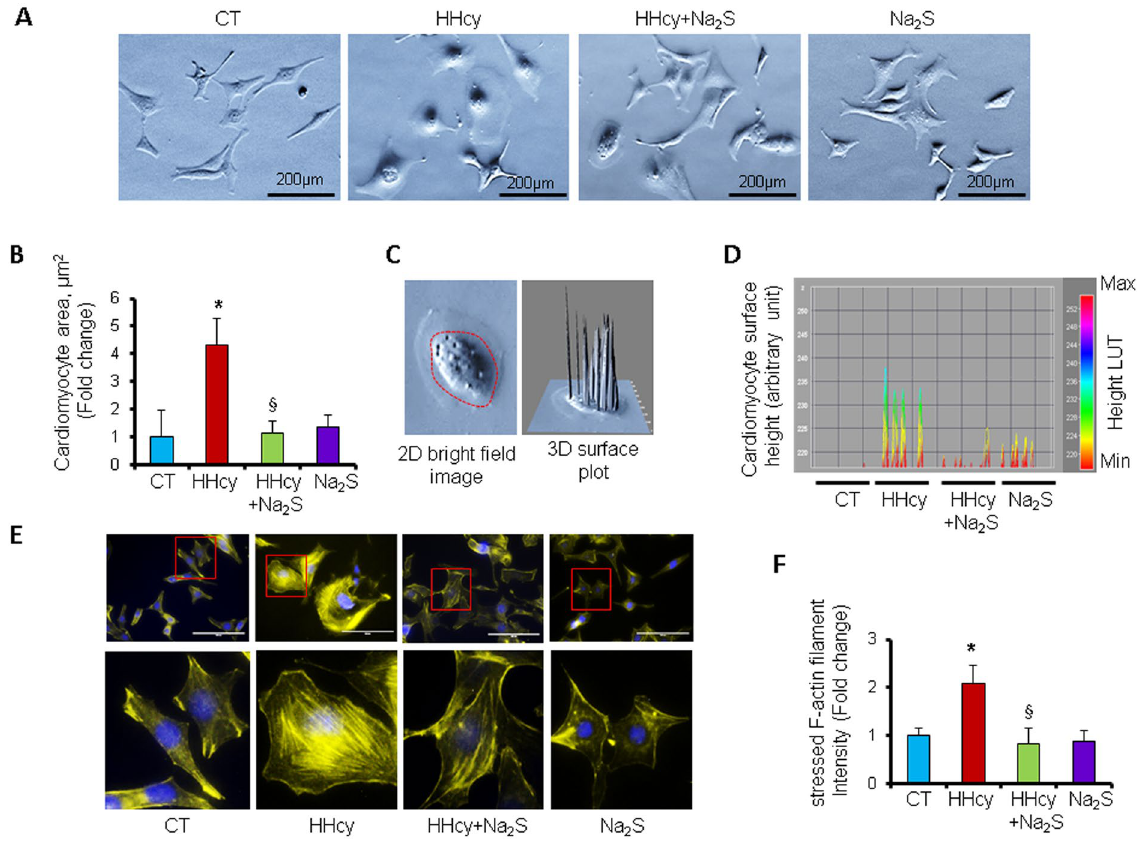
Figure 7. Hydrogen sulfide donor Na 2 S mitigates homocysteine-mediated increase in cardiomyocyte area and F-actin expression in HL1 cardiomyocytes. ( A ) Representative phase-contrast microscopic images showing the relative size of cardiomyocytes treated with either nothing (CT), 100 µ M of Hcy (HHcy), HHcy with 30 µ M of Na 2 S (HHcy + Na 2 S), or 30 µ M of Na 2 S (Na 2 S). ( B ) Quantification of cardiomyocyte area in the above four groups of cardiomyocytes. Values are represented as mean ± SEM. n = 20 cells per group from three independent experiments. ( C ) Representative 2D phase-contrast and 3-dimentional (3D) shadow spike plot of a cardiomyocyte. ( D ) The shadow spikes converted lookup table (LUT) showing the arbitrary height of cardiomyocytes in the above four groups. ( E ) Representative F-actin staining on cardiomyocytes from the above four groups. ( F ) Quantification of intensity of F-actin from ‘E’. The increased F-actin intensity indicates cardiomyocyte hypertrophy. Values are represented as mean ± SEM, n = 20 cells per group. p < 0.05 is considered statistically significant. “ * ” Represents statistically significant values when compared to the untreated control, and “§” represents statistically significant values when compared to the HHcy + Na 2 S treated cells. Scale bars: A; 200 μ m, E; 100 μ